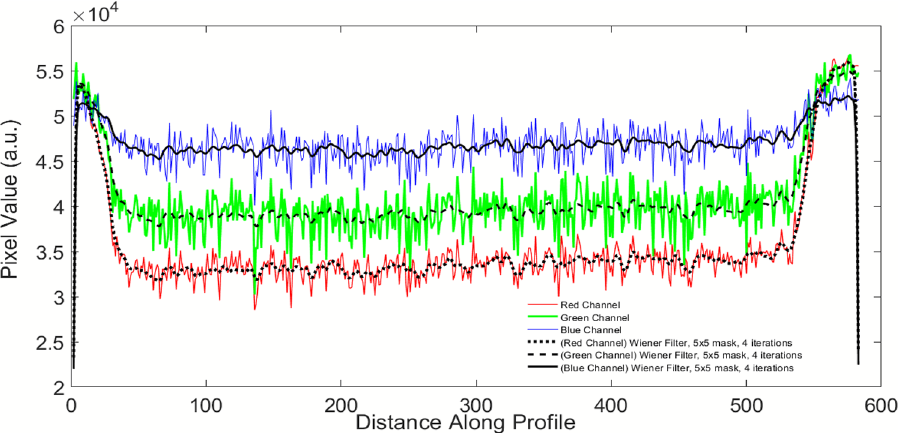
Figure 6. Pixel values in red, green and blue color channels of scanner.